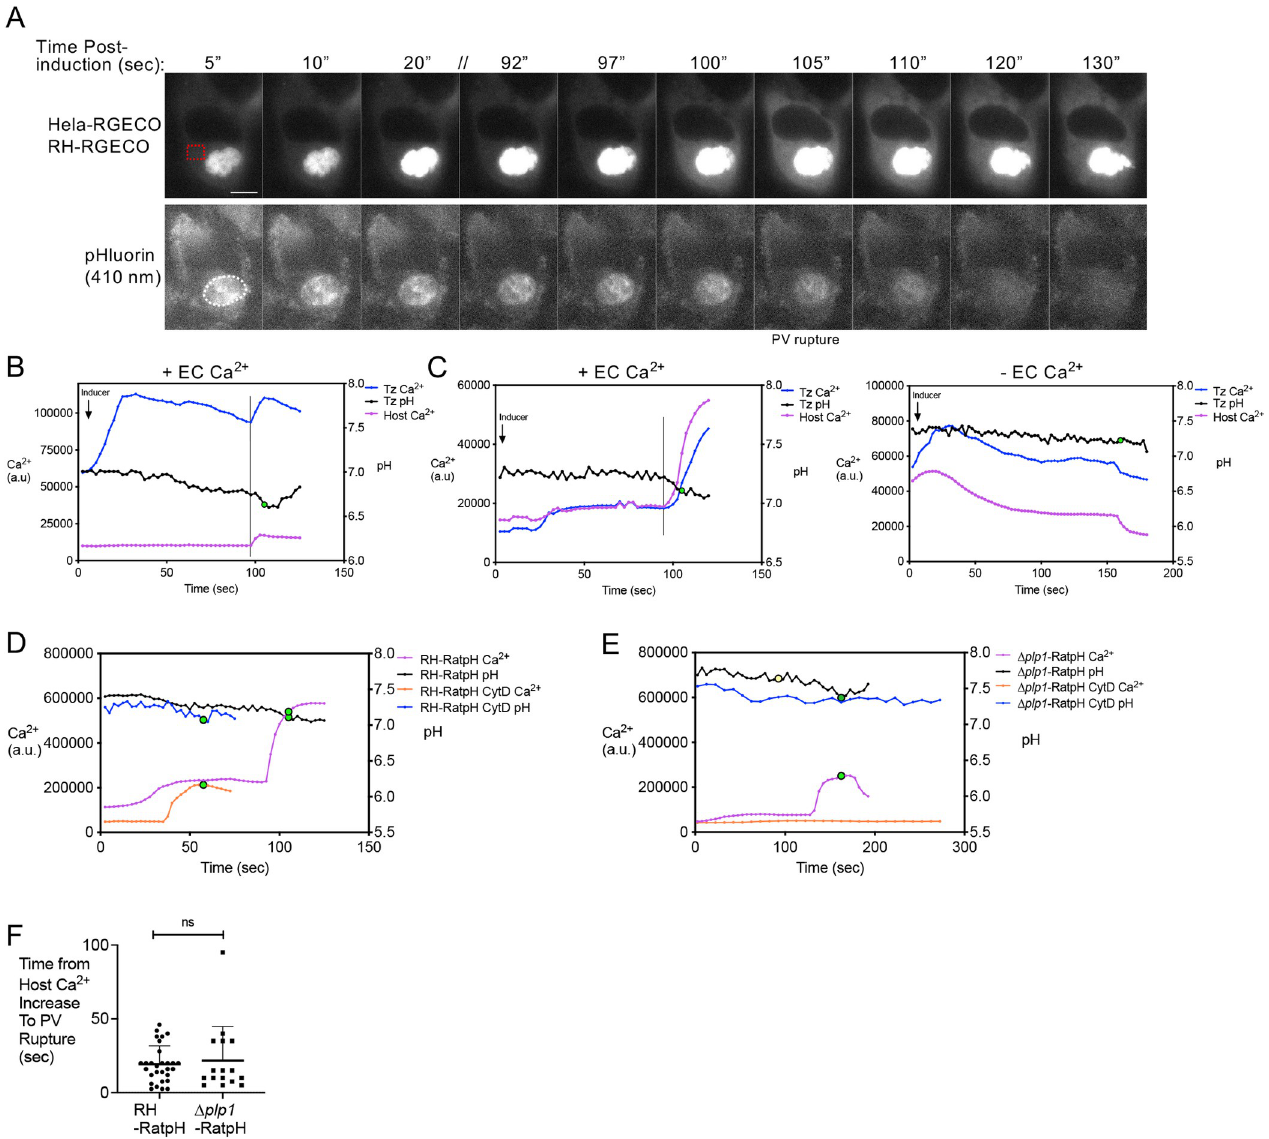
Fig 4. Host cytosolic calcium increases prior to PV rupture. A) Still images of time-course of HeLa-RGECO host Ca 2+ levels and PV rupture (loss of pHluorin from PV) following zaprinast induction. // indicates a gap in time. Scale bar, 10 μ m. Dashed red outline indicates the region of the host cell used to analyze the RGECO fluorescence in B), and the dashed white outline indicates the PV used to analyze pH (pHluorin) and tachyzoite Ca 2+ (RGECO). B) Tracings of host and tachyzoite Ca 2+ levels (left axis) and PV pH (right axis) of vacuole shown in A. A vertical line denotes the time point after which host Ca 2+ levels increase and near when the PV pH decreases. Blue trace, parasite Ca 2+ ; black trace, PV pH; purple trace, host cell Ca 2+ . a.u., arbitrary units. C) Representative tracings of an HFF host cell preloaded with Cal-590-AM, infected with RH-RatpH-RGECO parasites, and induced with zaprinast in Ringer’s buffer with or without Ca 2+ . A vertical line denotes the time point after which host Ca 2+ levels increase and when the PV pH decreases. D,E) Cal-590-AM- loaded HFF cells infected with RH-RatpH (D) or Δ plp1 -RatpH (E), following treatment without or with CytD. Measurements of host Ca 2+ (left axis) and PV pH (right axis). Purple trace, host Ca 2+ ; black trace, PV pH; orange trace, host Ca 2+ with CytD-treated parasite, blue trace, PV pH with CytD-treated parasite. Yellow data point indicates the start of motility (in E) and green data points indicate PV rupture (in D and E). F) Time from host Ca 2+ (Cal-590 fluorescence) increase to PV pHuorin release in host cells infected with RH-RatpH (29 vacuoles) or Δ plp1 -RatpH (16 vacuoles). A two-tailed student’s t -test was performed. ns, not